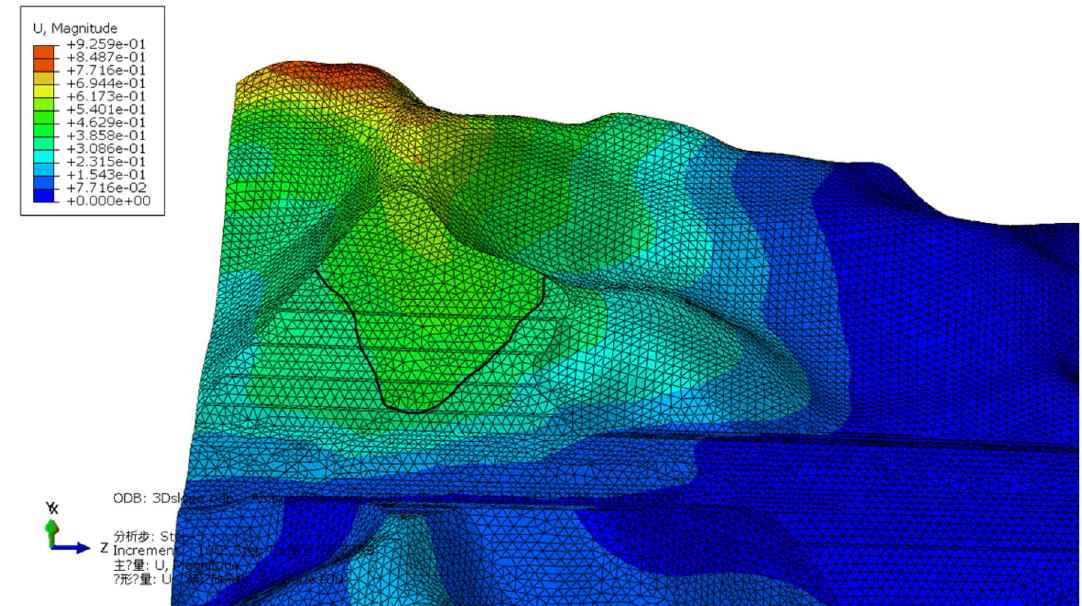
Figure 17. Potential slip surface determined by the equivalent plastic strain.